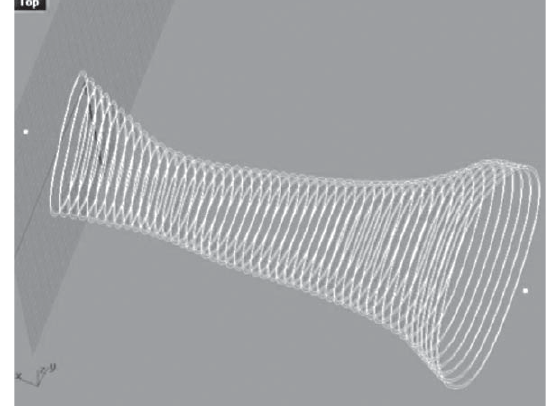
Fig. 2. Corresponding contour